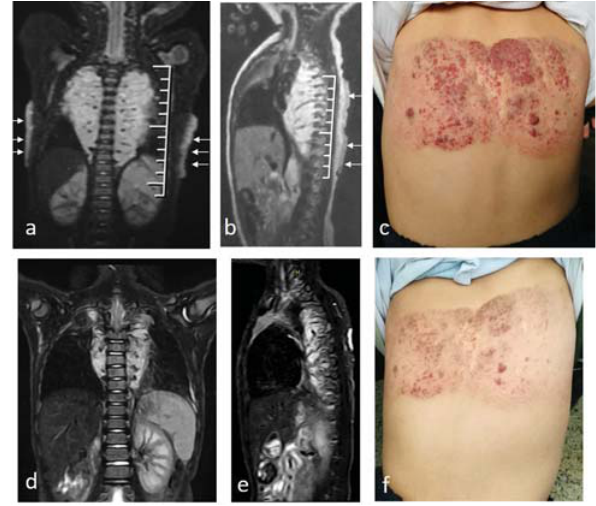
Fig. 1 First case of a boy with cutaneous back and posterior mediastinal hemangiomas. ( a,b ) magnetic resonance imaging ([MRI] coronal and sagittal) performed at the age of 3 months (before treatment) demonstrating the presence of large intrathoracic posterior mediastinal (paravertebral) hemangioma (bright T2 signal with characteristic intralesional fl ow voids). White arrows are pointing to cutaneous back hemangioma in ( a ) and ( b ). ( c ) The appearance of back hemangioma at the time of referral (2 years old). ( d – f ) Follow-up at the age of 3 years demonstrating marked regression of the mediastinal lesions on MRI ( d,e ), as well as regression of the cutaneous back hemangioma after propranolol